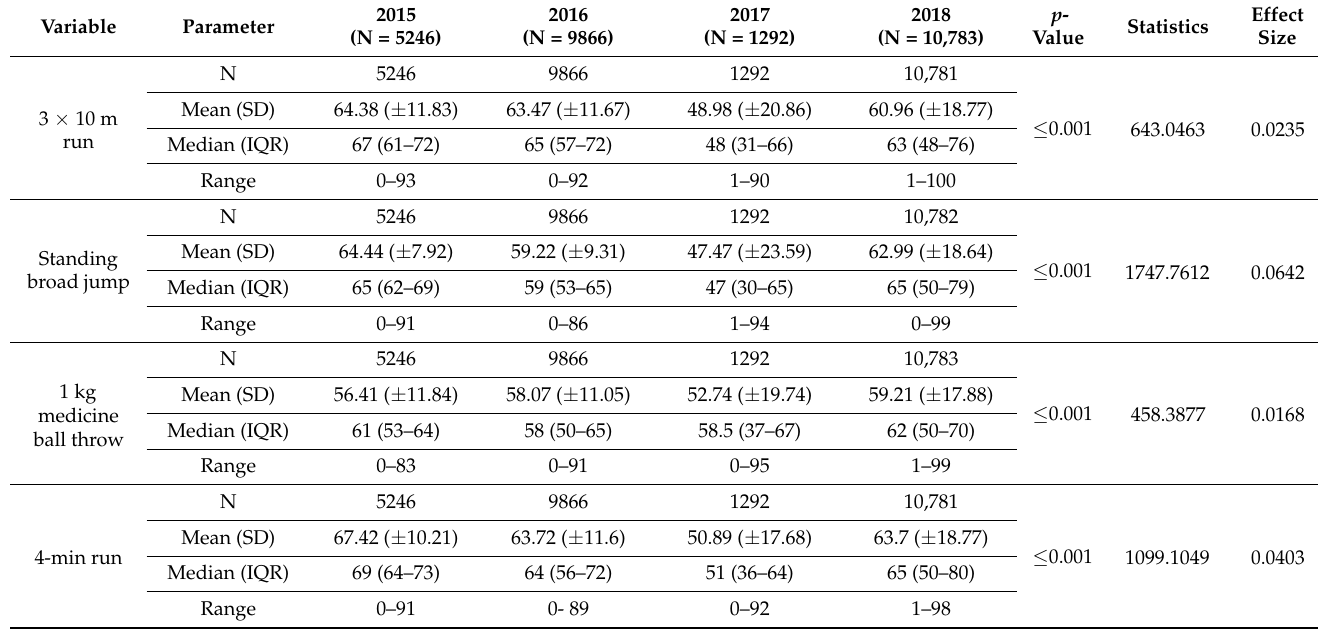
OSF test scores (points) in particular years in which the study was conducted (Kruskal–Wallis